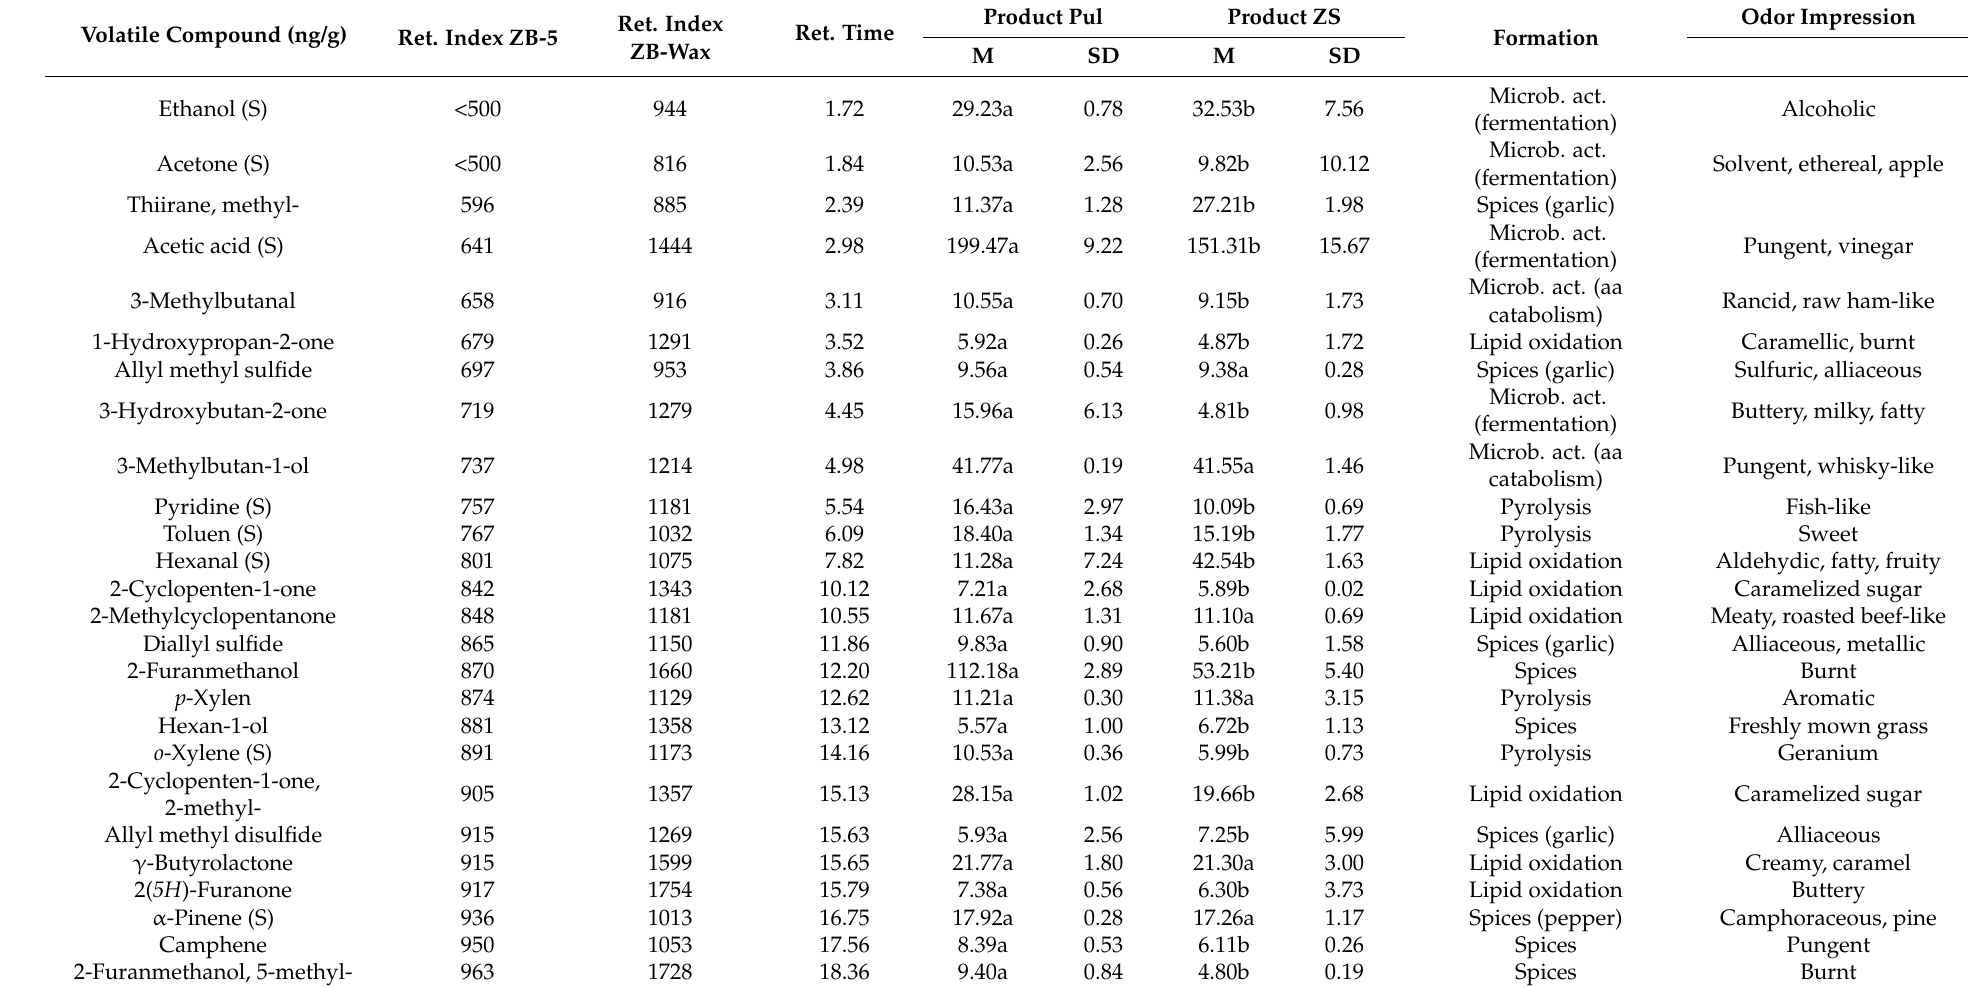
Table 5. Volatile compounds of dry-cured ham—odor impression according to Flavornet; The Good Scents Company; Resconi et al.